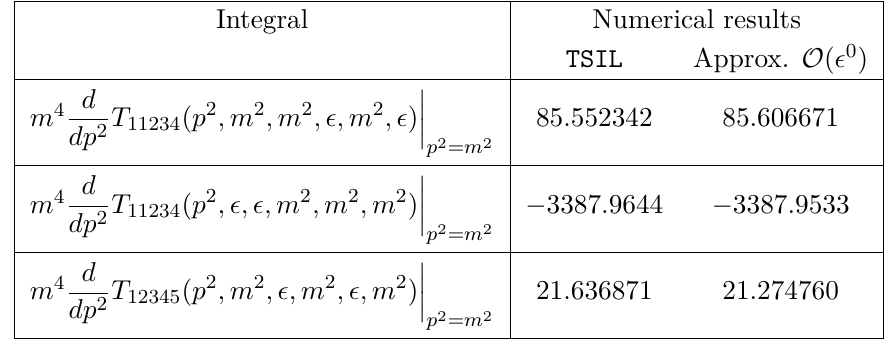
Table 2. Example values of the derivatives of T 11234 and T 12345 , multiplied by m 4 to obtain dimensionless numbers, computed by TSIL and with the approximate expansions of eq. (B.7). The mass values are chosen according to ( a ) in eq. (B.4). The numerical derivatives that are necessary for the TSIL column are computed with a step size of δ = 10 − 3 GeV 2